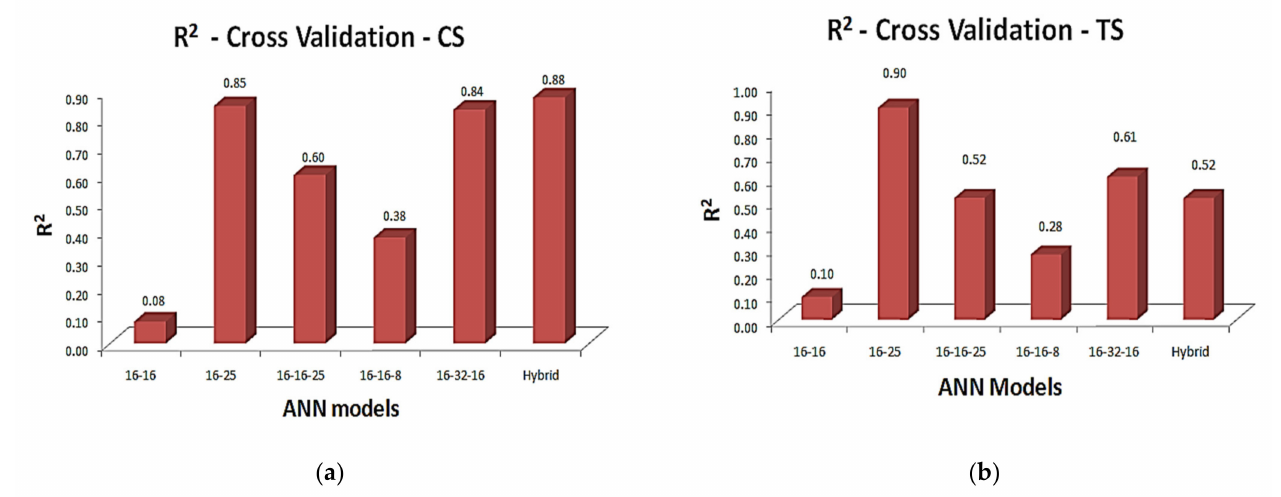
Figure 7. ( a ): Regression analysis of cross-validation of ANN-I and tacked-together models; ( a ) com- pressive strength, ( b ) tensile